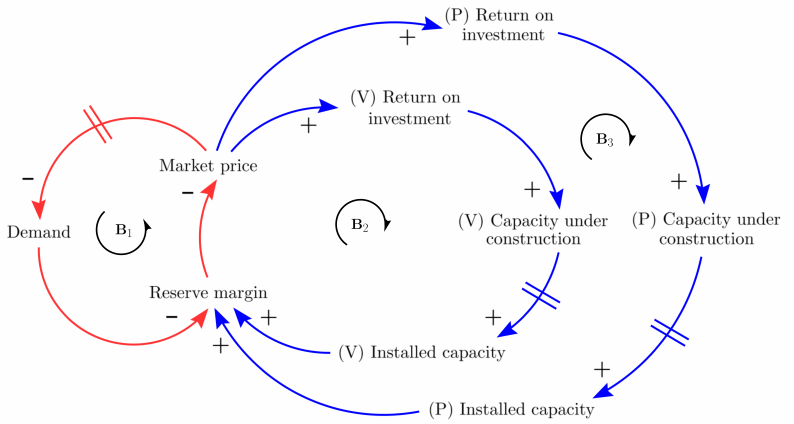
Figure 1. Dynamic hypothesis of the electricity system. It was modified from the one in [28]. V refers to the variable generation, and P refers to the permanent generation. Reprinted with the permission of Reference [13]. Copyright 2018